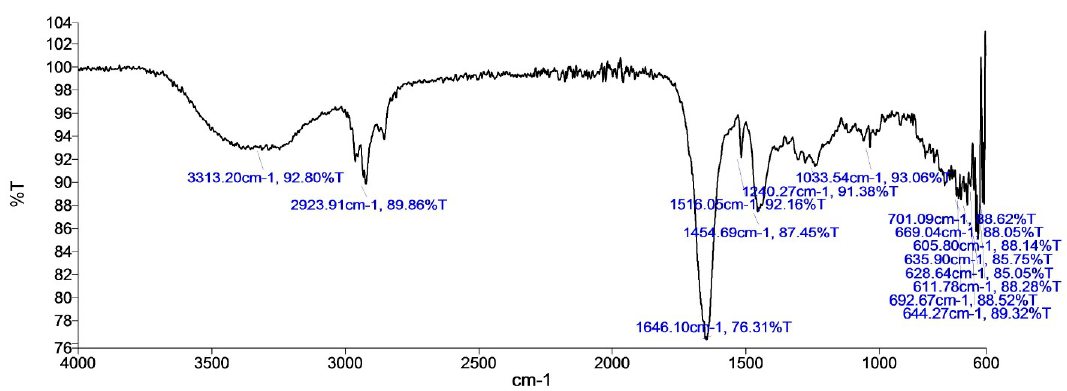
Figure 4. FT-IR spectrum of the active extract of Streptomyces sp.S2A.